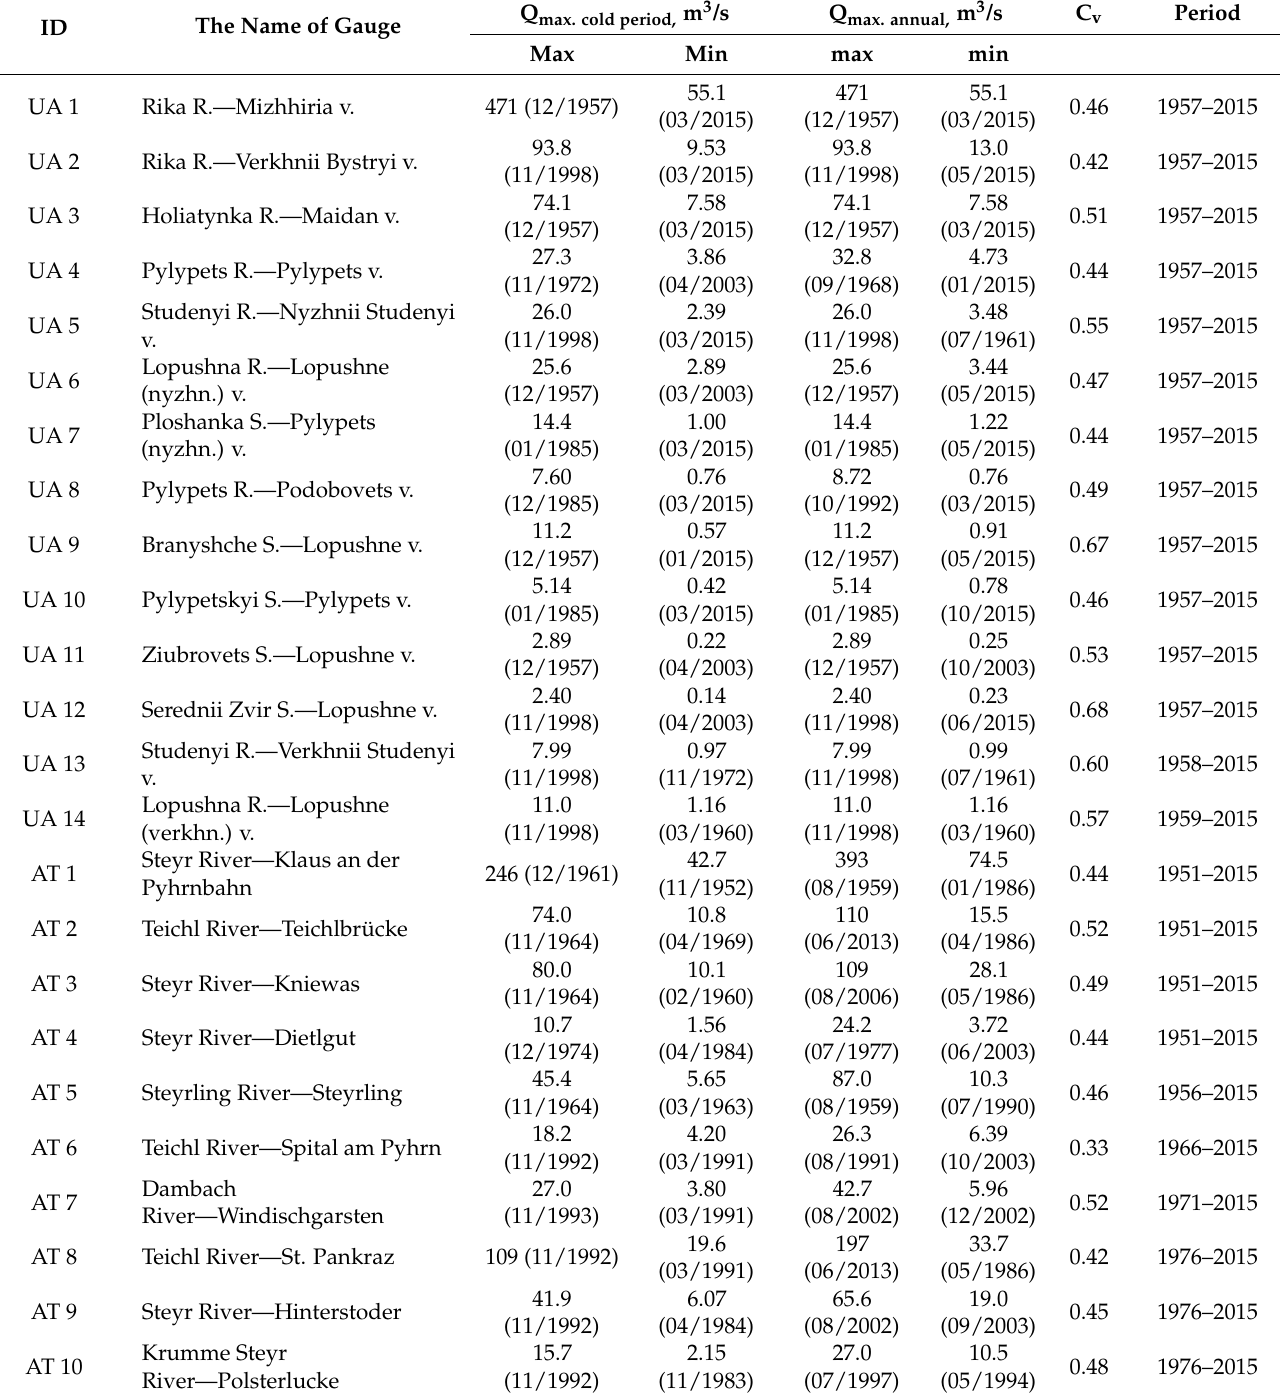
Table 3. The length of flood records, coefficient of variation Cv (November–April) and the